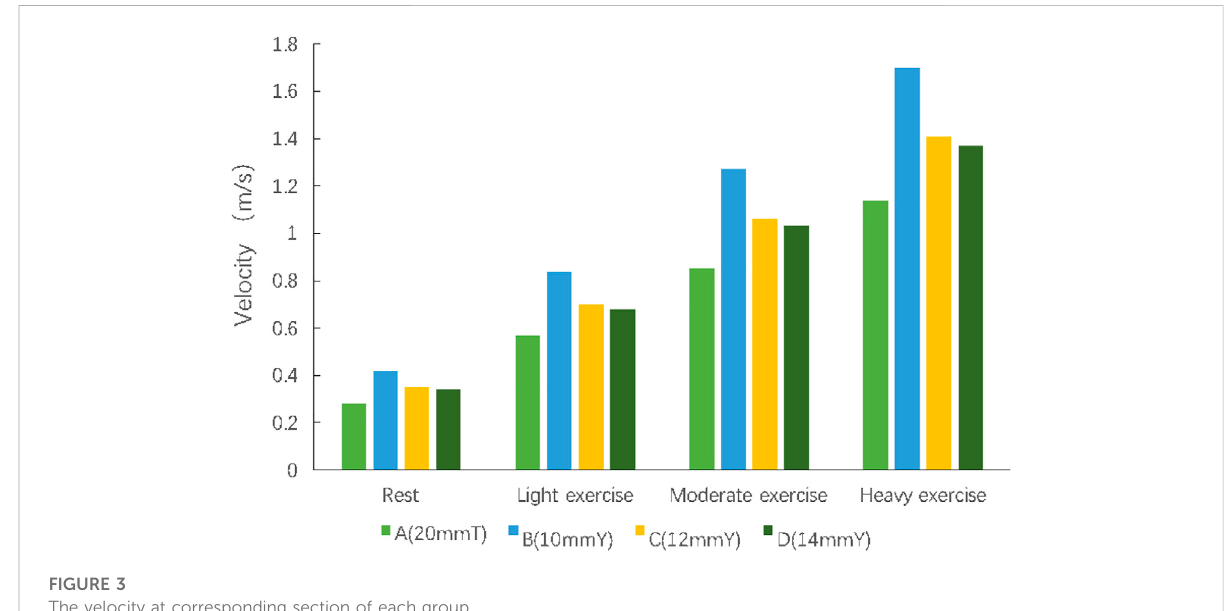
FIGURE 3 The velocity at corresponding section of each group.